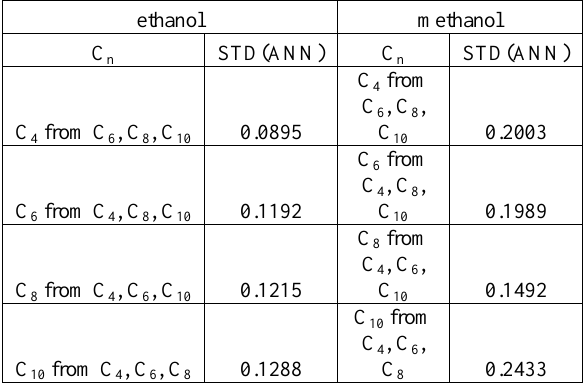
Table 5.2 Standard deviation of ANN prediction in compositional viscosity for binary [C n -mim][NTf 2 ]-ethanol and methanol system at temperature range T=293-328K